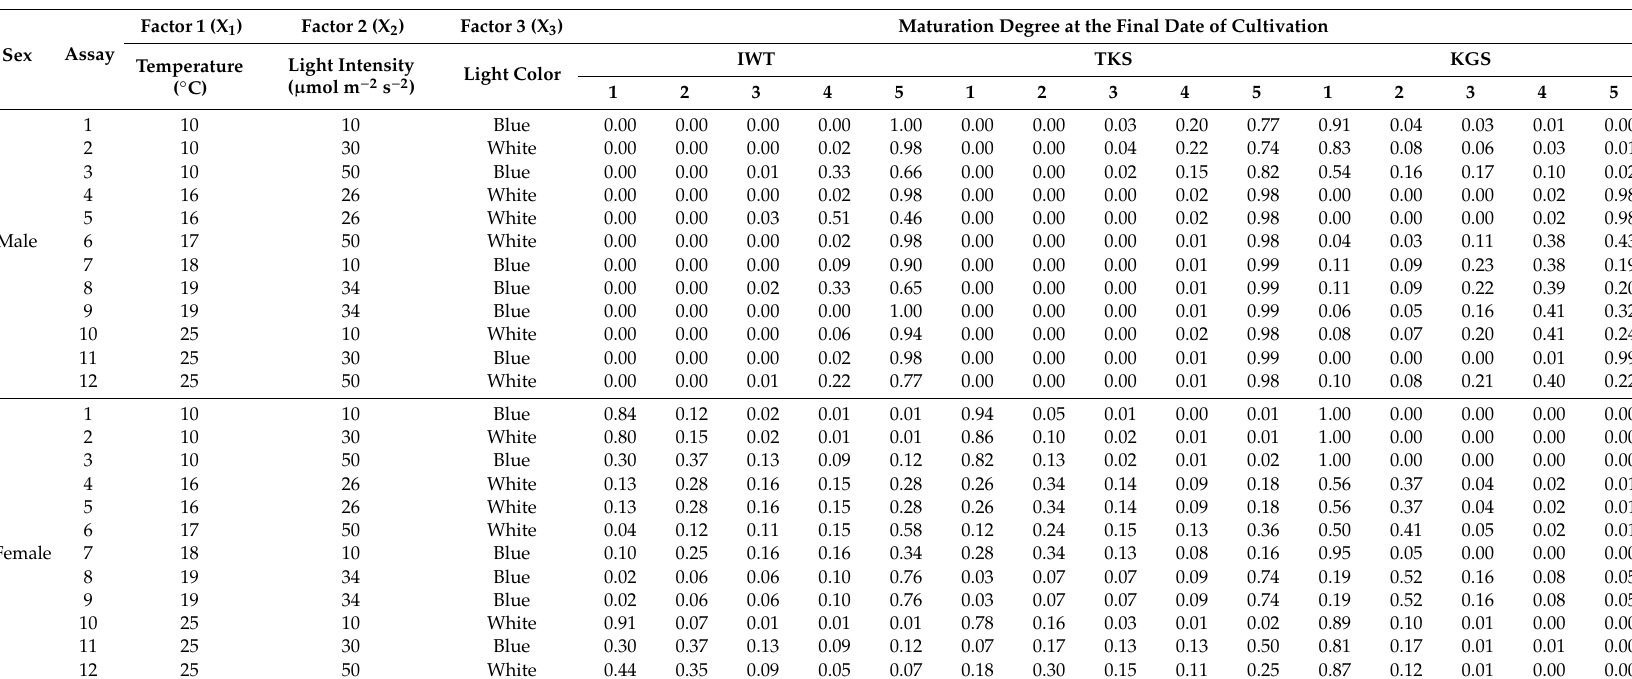
Table 2. Results of experiments to observe the e ff ects of environmental parameters on maturation (stages I to V) of male (upper matrix) and female (lower matrix) gametophytes of Undaria pinnatifida. Observations: probability of maturation for each group on cultivation day